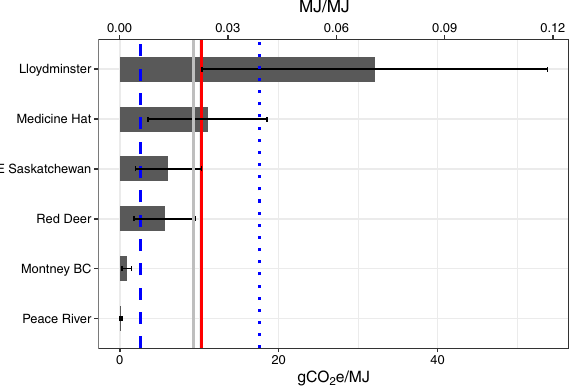
Figure 2. Emission intensities for each region included in this study (horizontal grey bars). The top axis shows intensities as a function of megajoule emitted per megajoule produced (MJ/MJ), and the bottom axis displays intensities as a function of grams of CO 2 equivalent emitted per megajoule produced (gCO 2 e/MJ). Emission intensity uncertainty ranges are represented via the black error bars, which includes uncertainty from both emission rate and production values. The solid grey vertical line is the overall average from this study, the solid vertical red line is the global lifecycle (well-to-refinery, including all greenhouse gases) average reported in Masnadi et al. (2018) 30 , the dotted blue line shows their estimate for Canada (based on data from 84 oil fields), and the blue thick dashed line is their global average intensity for CH 4 only 30